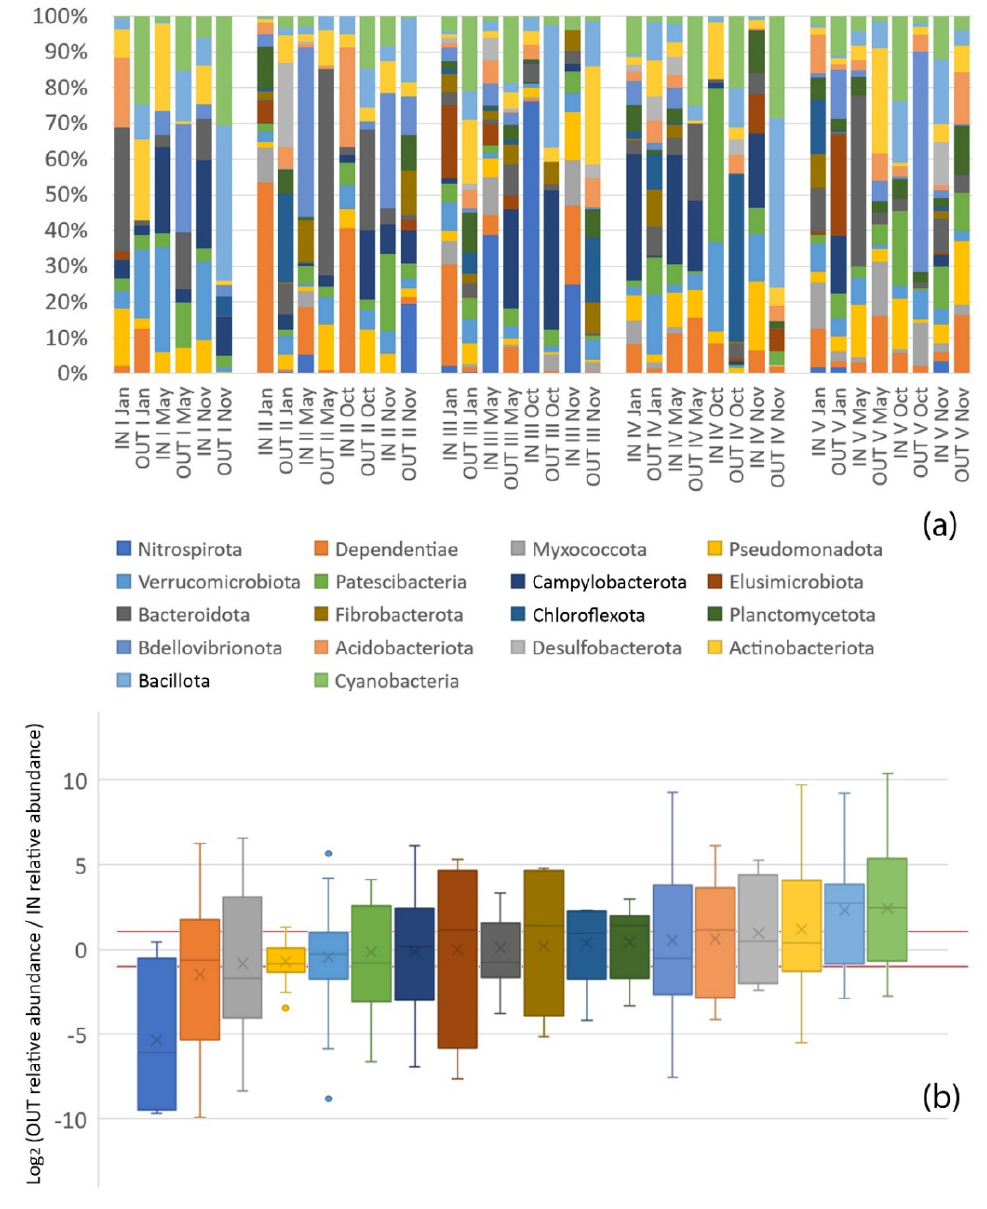
Figure 4. ( a ) Proportion of the different phyla present in samples collected upstream (IN) and downstream (OUT) for the five (I–V) investigated hydrokarst systems. ( b ) Box plots showing the distribution of the ratios between downstream and upstream locations on a Log2 scale. The ratios were calculated per site per time point. Red lines mark +1 and − 1, representing a 2-fold increase or decrease,